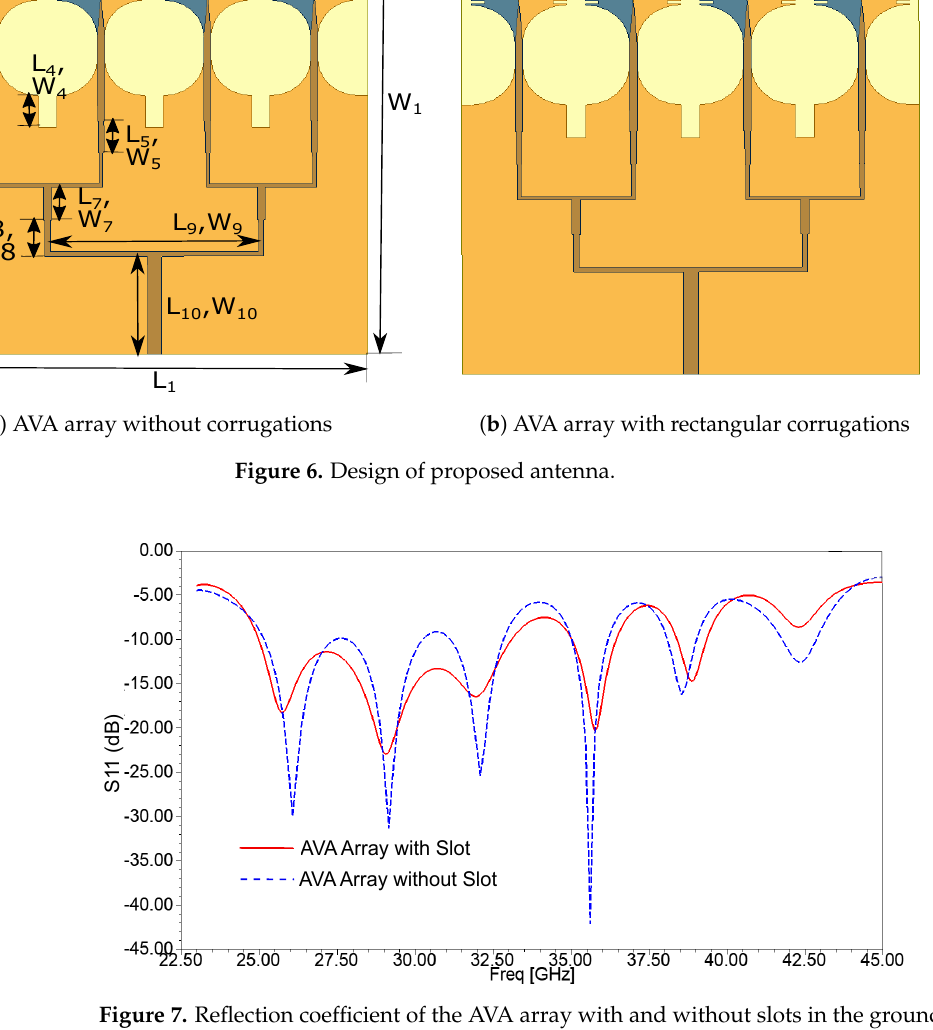
Figure 7. Reflection coefficient of the AVA array with and without slots in the ground.